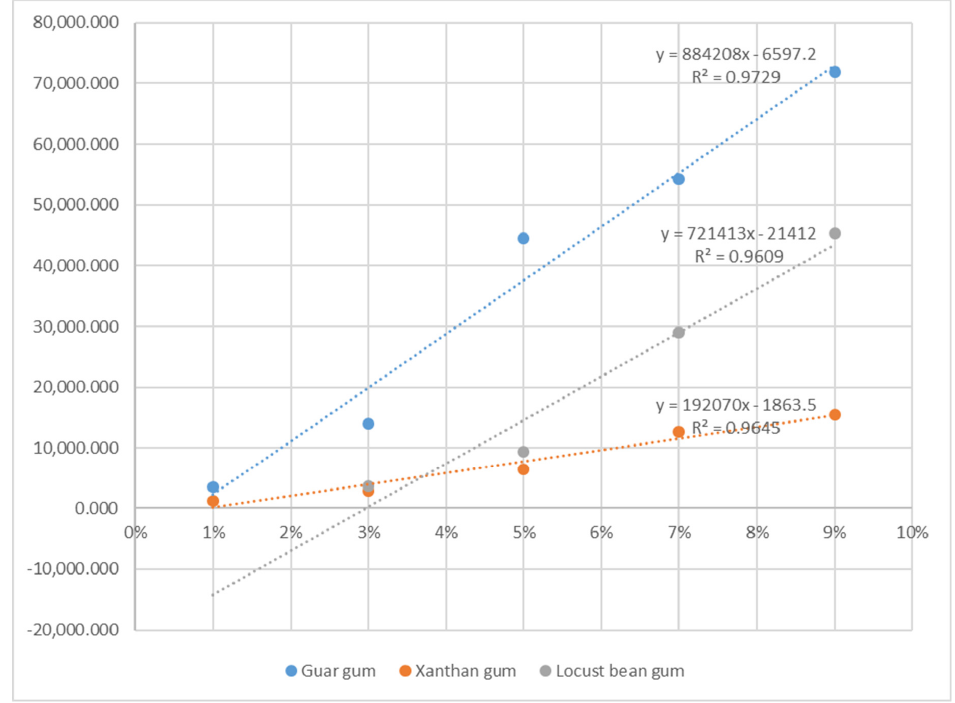
Figure 1. Regression equation for hardness of sea buckthorn jelly added with gelling agent. The y-scale is “hardness (N/m 2 )”, and the x-scale is “gelling agent concentration